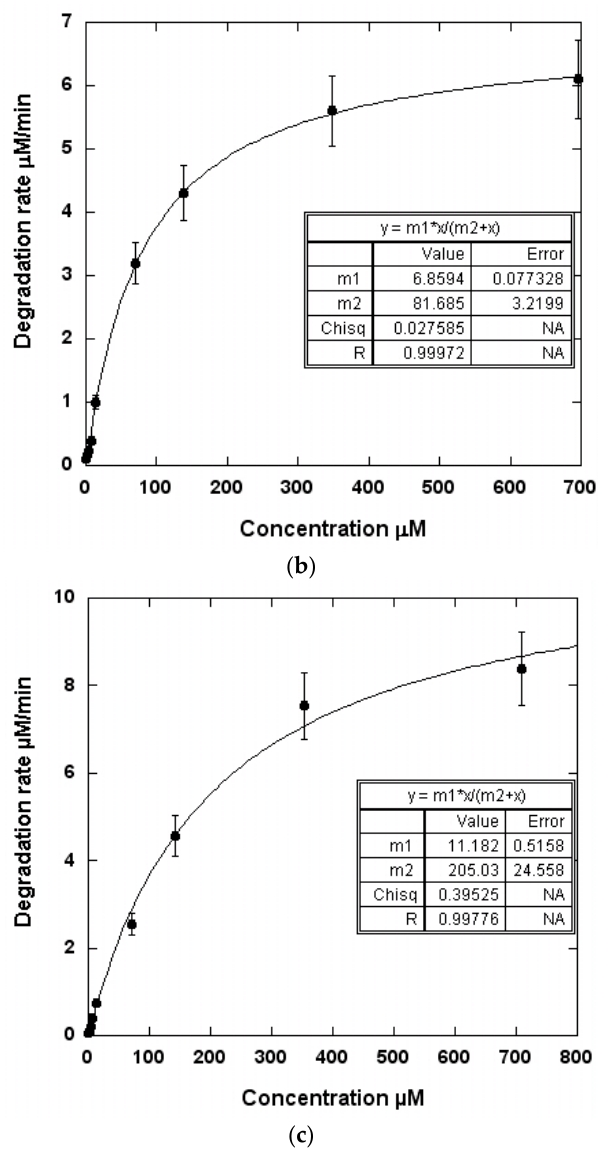
Figure 5. The degradation rates of BT as a function of the concentration( a ) in deionized water; ( b ) in natural water; ( c ) in sea water (352 kHz; volume = 300 mL; temperature = 21°C ± 1°C; electric input = 80 W).